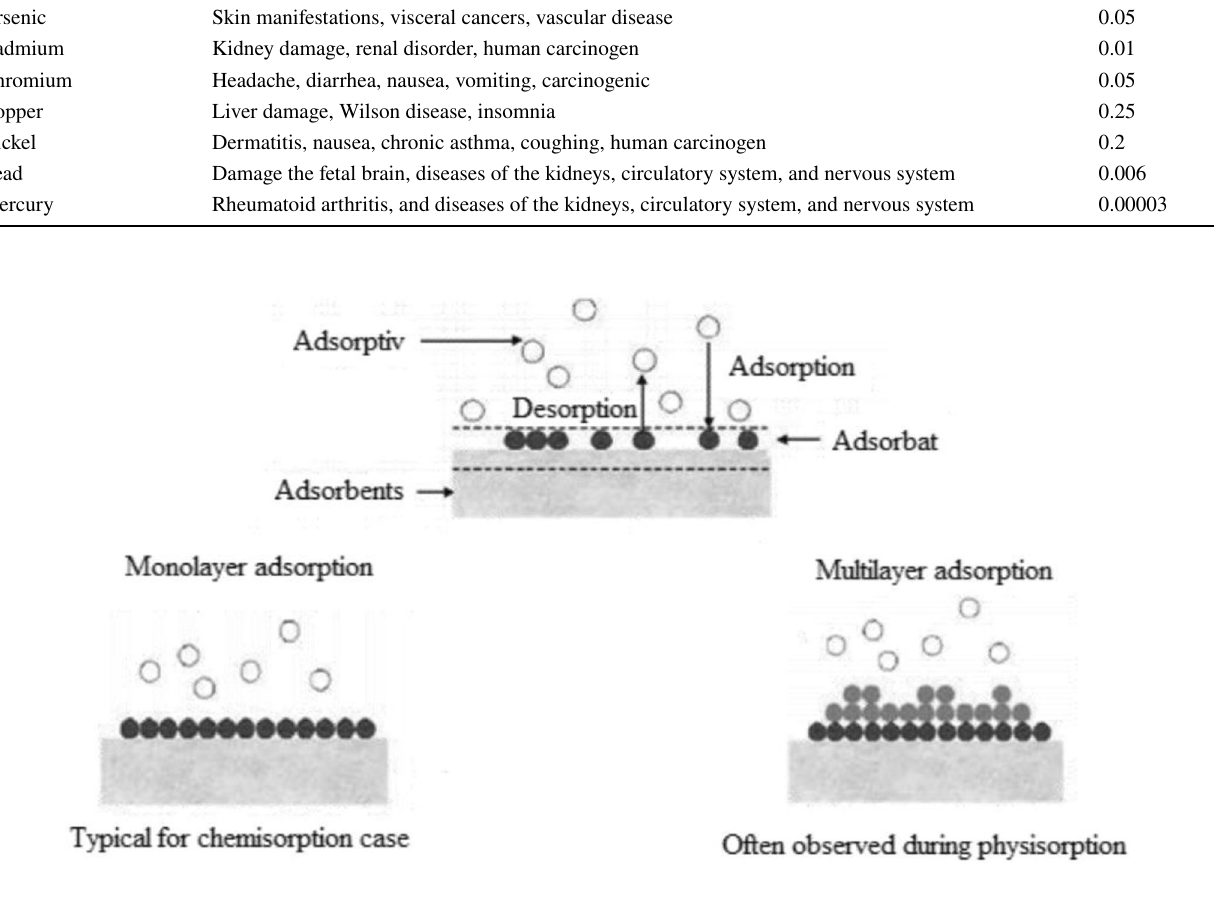
Fig. 6 Adsorption process and adsorption types created based on research by Christmann (2010)